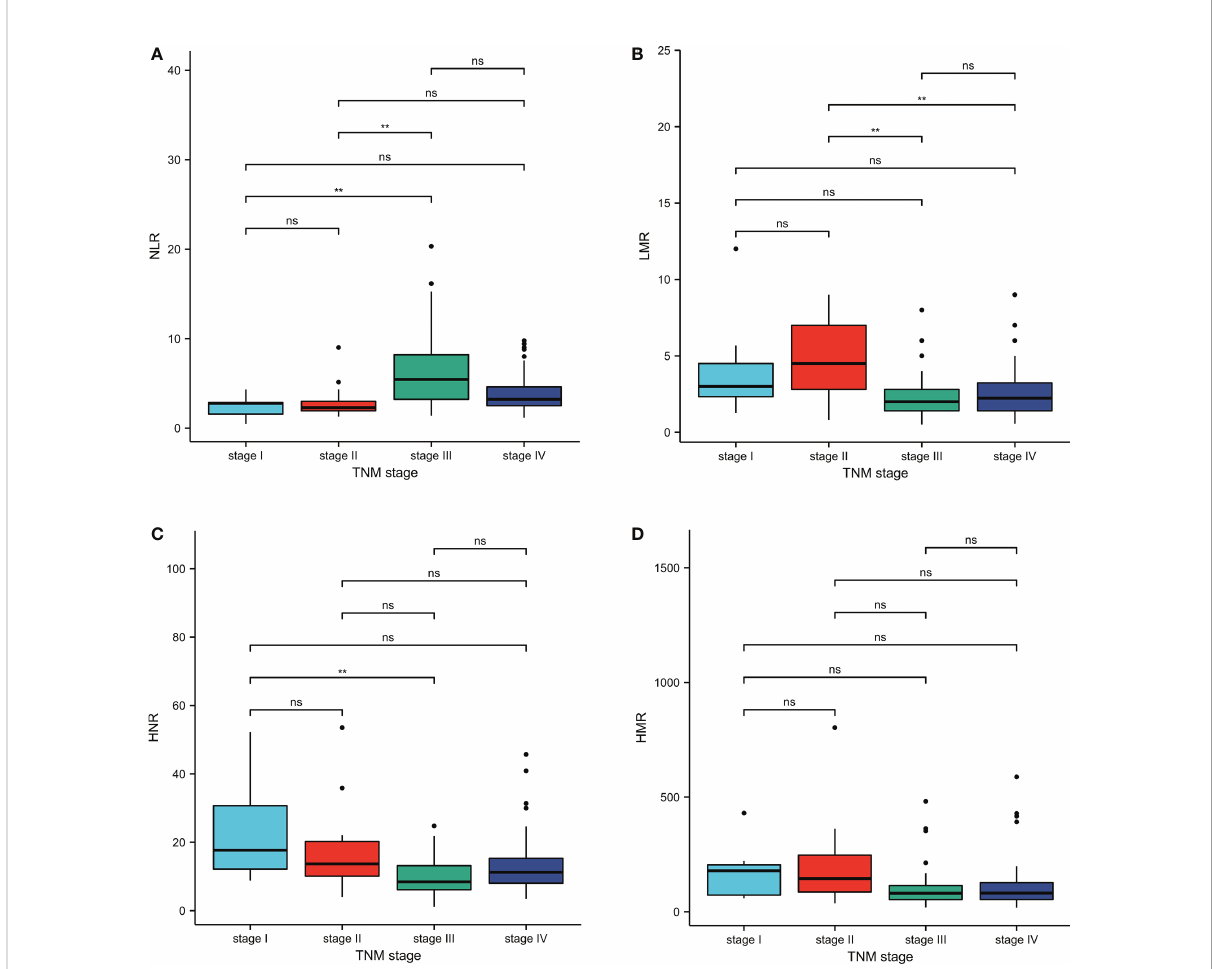
FIGURE 2 Inter-group comparison of NLR, LMR, HNR, and HMR in different stages of metastatic and non-metastatic NSCLC groups. (A) Inter-group comparison of NLR in different stages of metastatic and non-metastatic NSCLC groups. (B) Inter-group comparison of LMR in different stages of metastatic and non-metastatic NSCLC groups. (C) Inter-group comparison of HNR in different stages of metastatic and non-metastatic NSCLC groups. (D) Inter-group comparison of HMR in different stages of metastatic and non-metastatic NSCLC groups. ns, p ≥ 0.05;